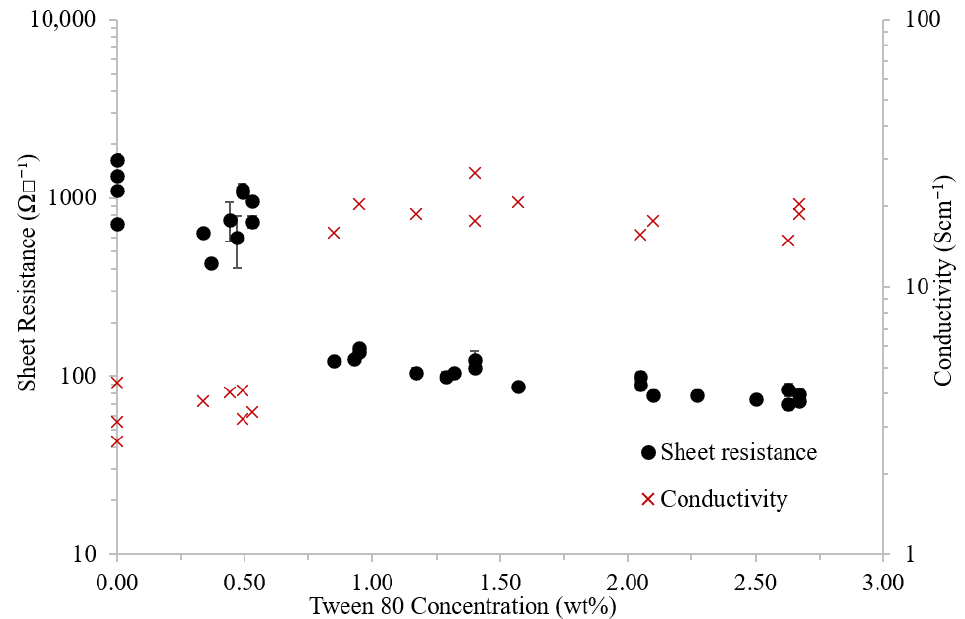
Figure 2. Sheet resistance ( Ω (cid:3) − 1 ) (black circle) and corresponding conductivity (S cm − 1 ) (red cross) Figure 2. Sheet resistance (Ω□ − 1 ) (black circle) and corresponding conductivity (S cm − 1 ) (red cross) of PEDOT:PSS films with various concentrations of Tween 80 (wt%). Error bars on sheet resistance of PEDOT:PSS films with various concentrations of Tween 80 (wt%). Error bars on sheet resistance show ± 1 standard deviation of 6 measurements across various locations on the film. show ± 1 standard deviation of 6 measurements across various locations on the film. Table 2. Summary of the parameters obtained for each of the PEDOT:PSS/Tween 80 films. Table 2. Summary of the parameters obtained for each of the PEDOT:PSS/Tween 80 films. Tween 80